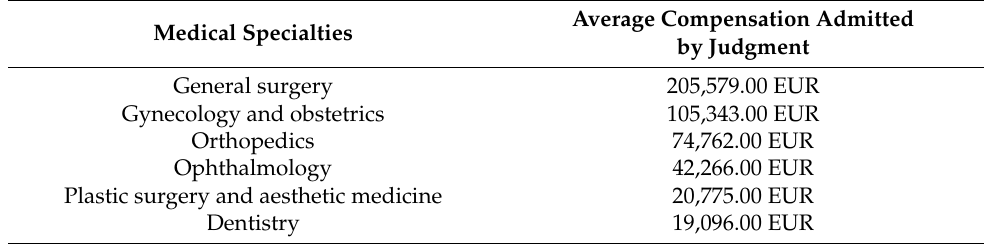
Table 2. Average compensation for the most involved